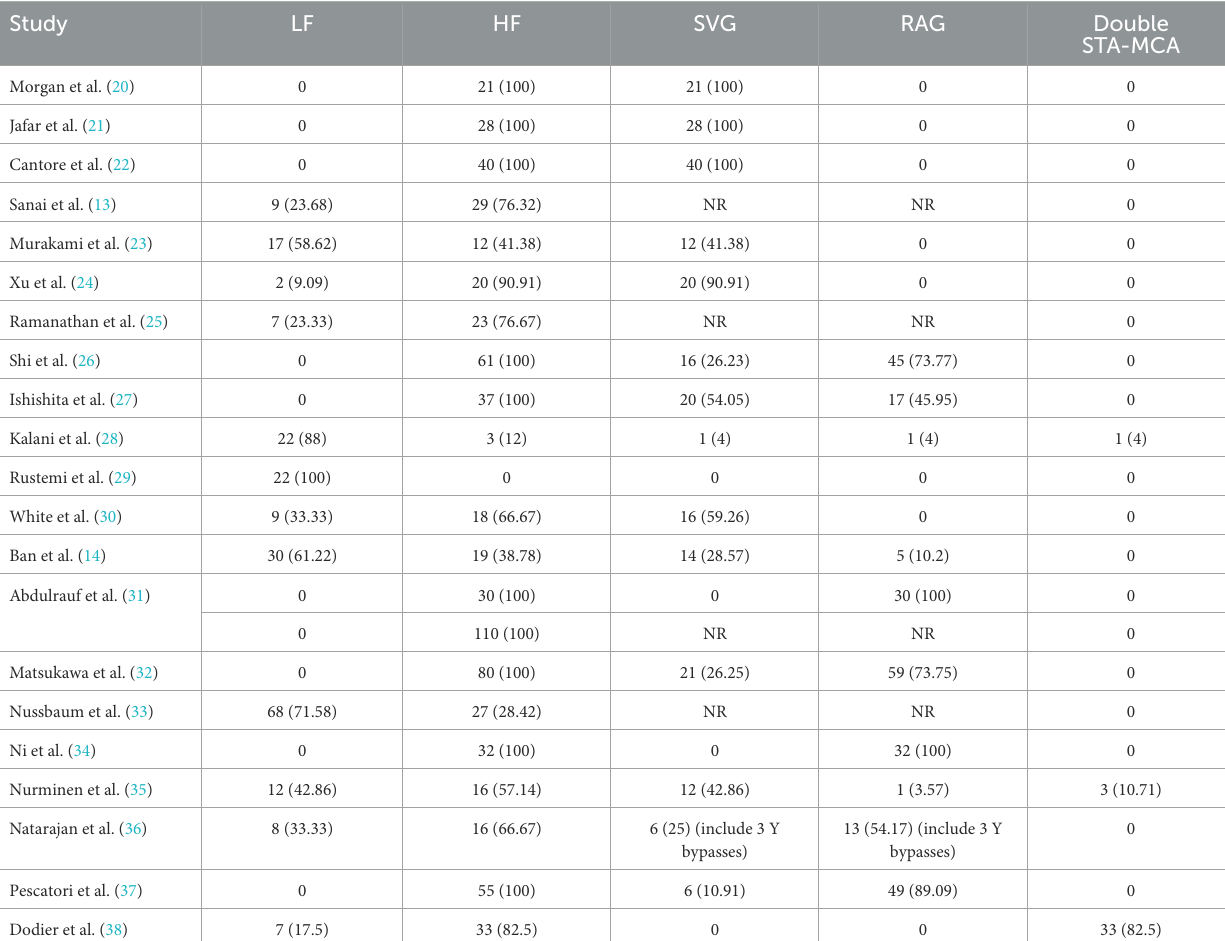
TABLE 2 Types of EC–IC bypass used in the included